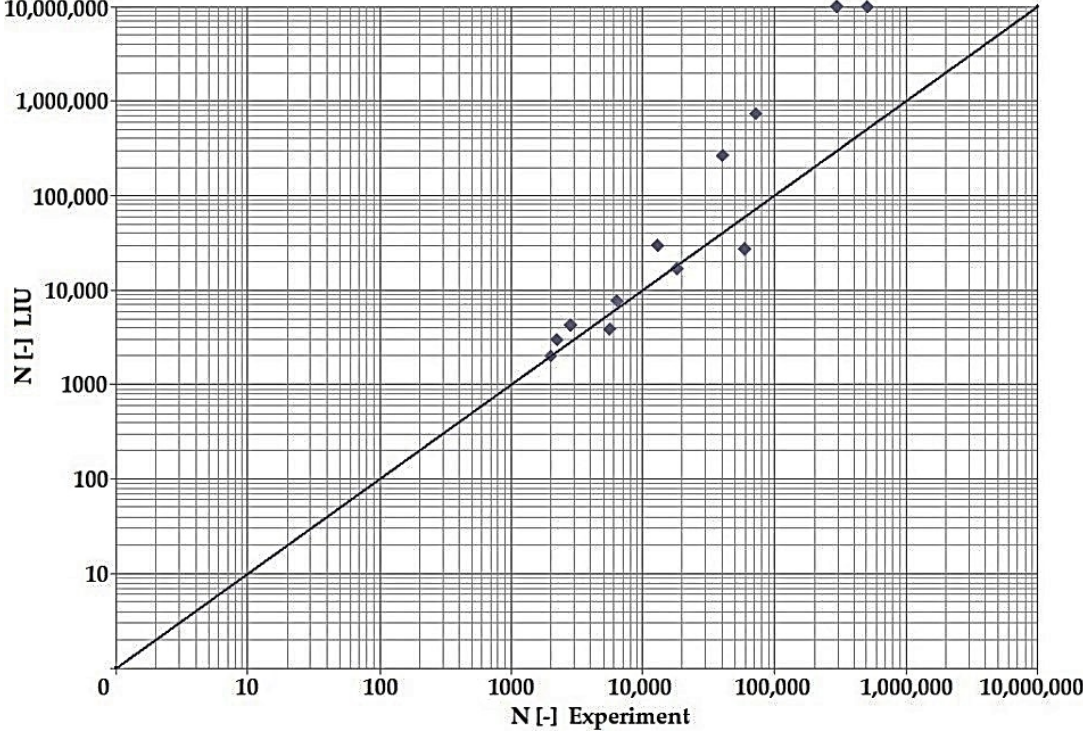
Figure 27. Dependence of theoretical and experimentally obtained number of cycles, Liu vs. experiment, phase shift 0°.